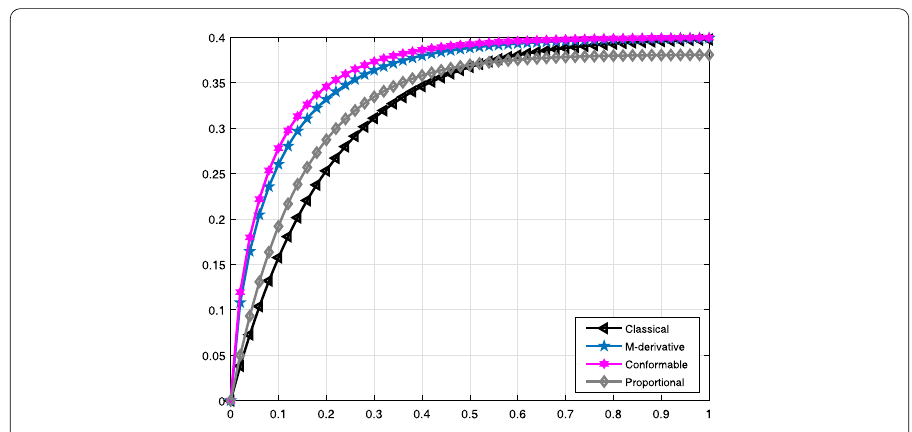
Figure 7 Comparative analysis when α = 0.75 and β = 0.5 for V i ( t )